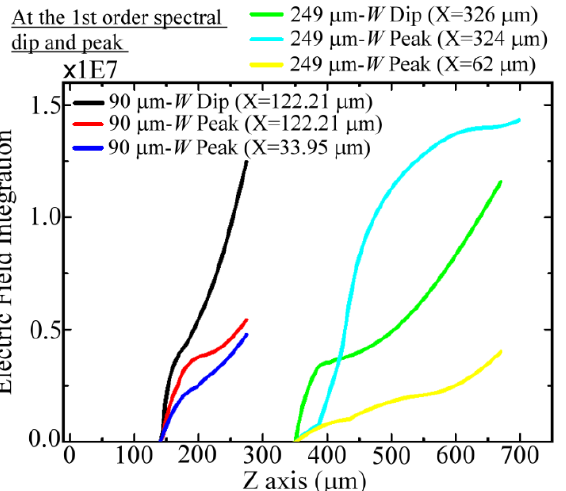
Figure 6. Simulated Z -axial E-field integrals of 90 and 249 μ m W MCWMs at the first-order spectral dips and peaks.